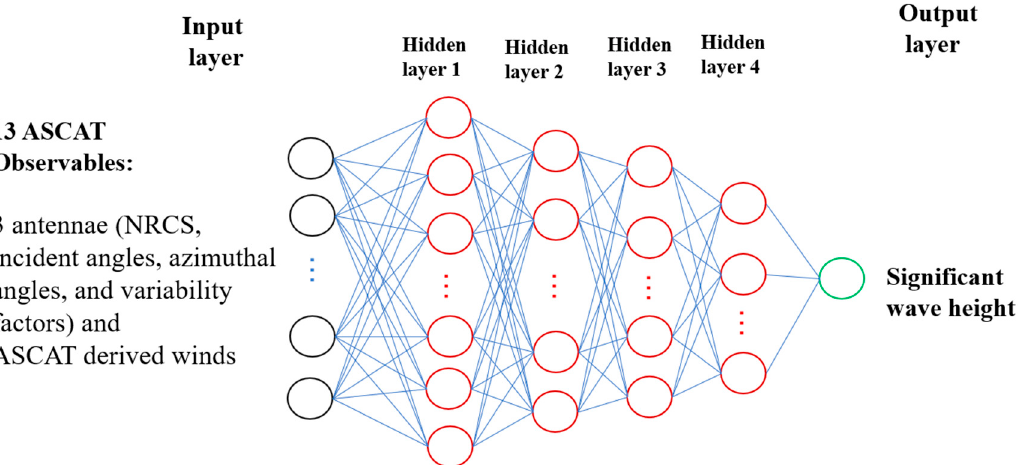
Figure 5. Architecture of the deep neural network.